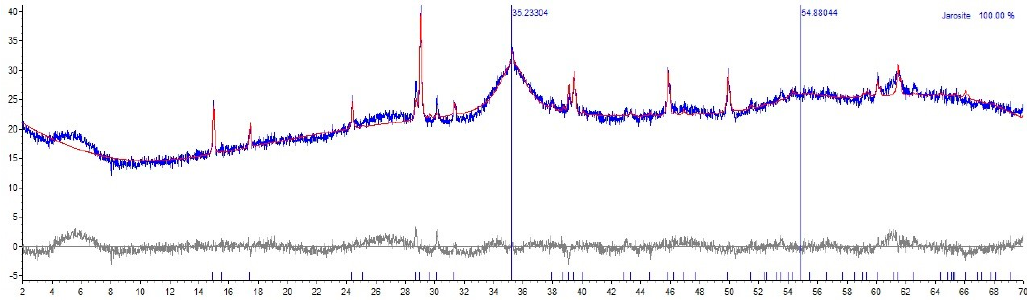
Figure 10. Mineralogy of a residue (jarosite) after bioleaching of PCBs (bio Fe 3+ 20 g/L; PD 5%; 40 °C; air 1 lpm; 600 rpm, pH 2). air 1 lpm; 600 rpm, pH